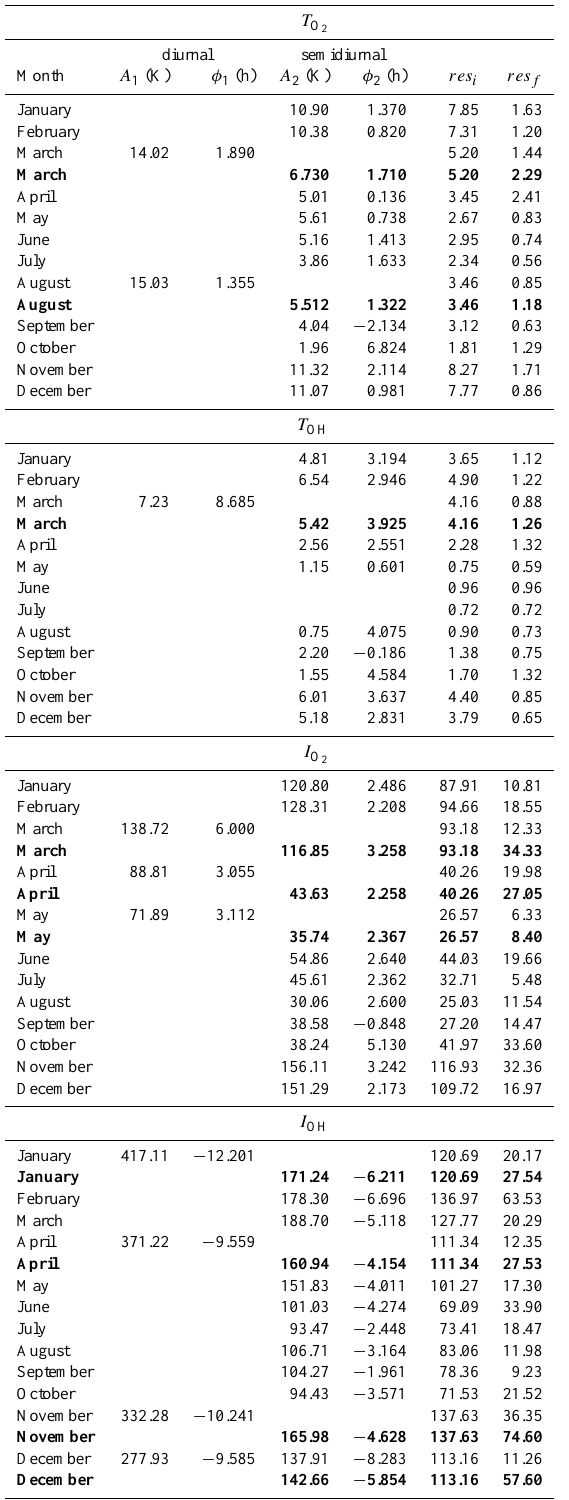
Table 4. Tidal amplitudes and phases that best fit the data (semidi- urnal tidal solutions with large standard deviations in